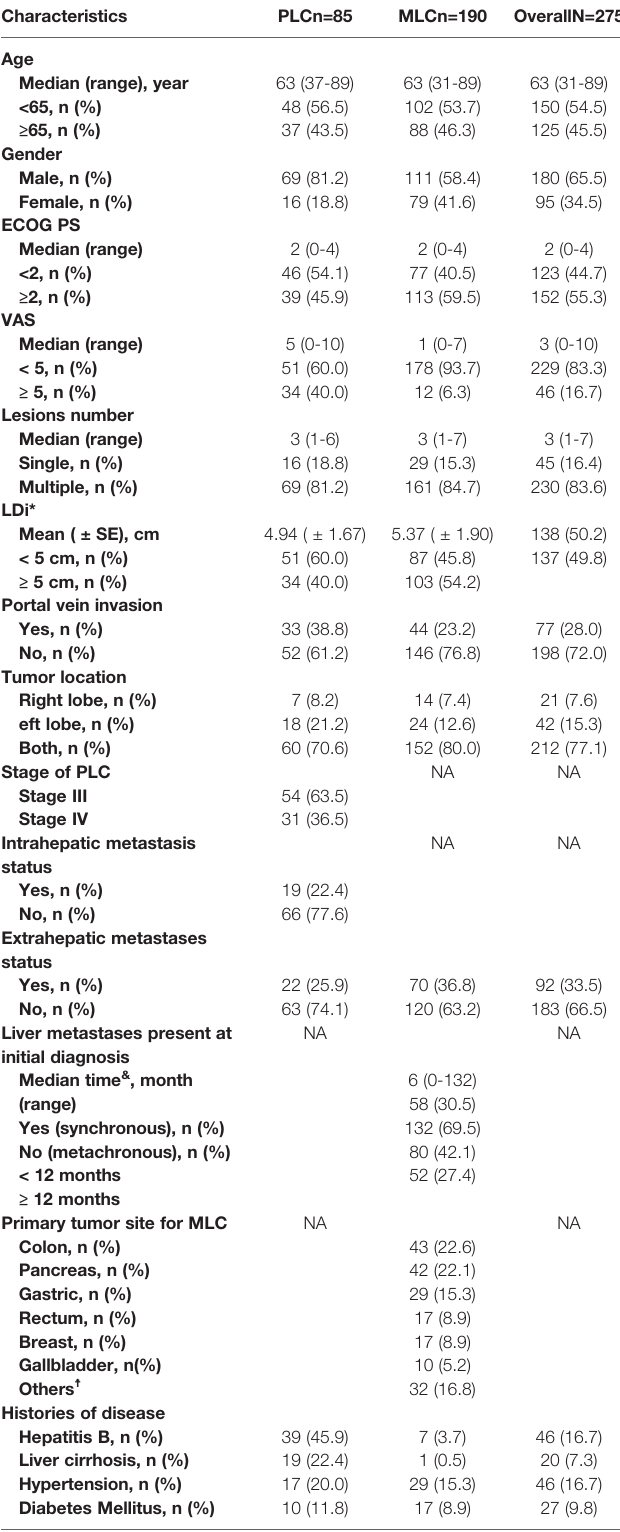
TABLE 1 | Baseline characteristics of patients and tumors.